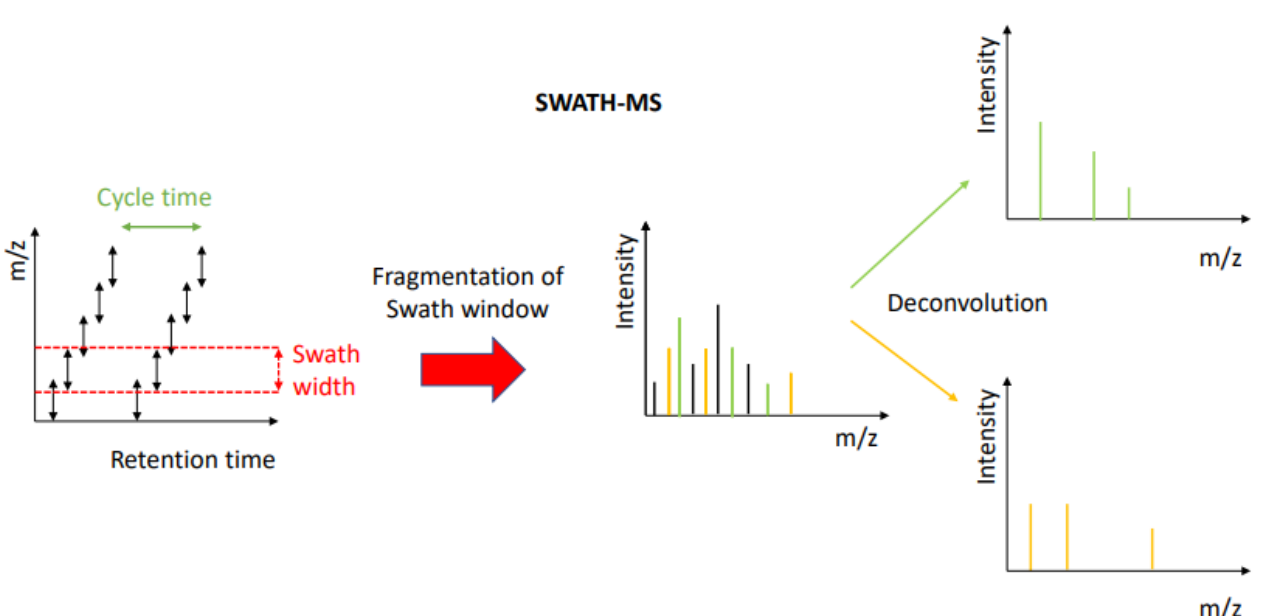
Figure 4. Schematic of DIA fragmentation of two compounds (green and yellow).